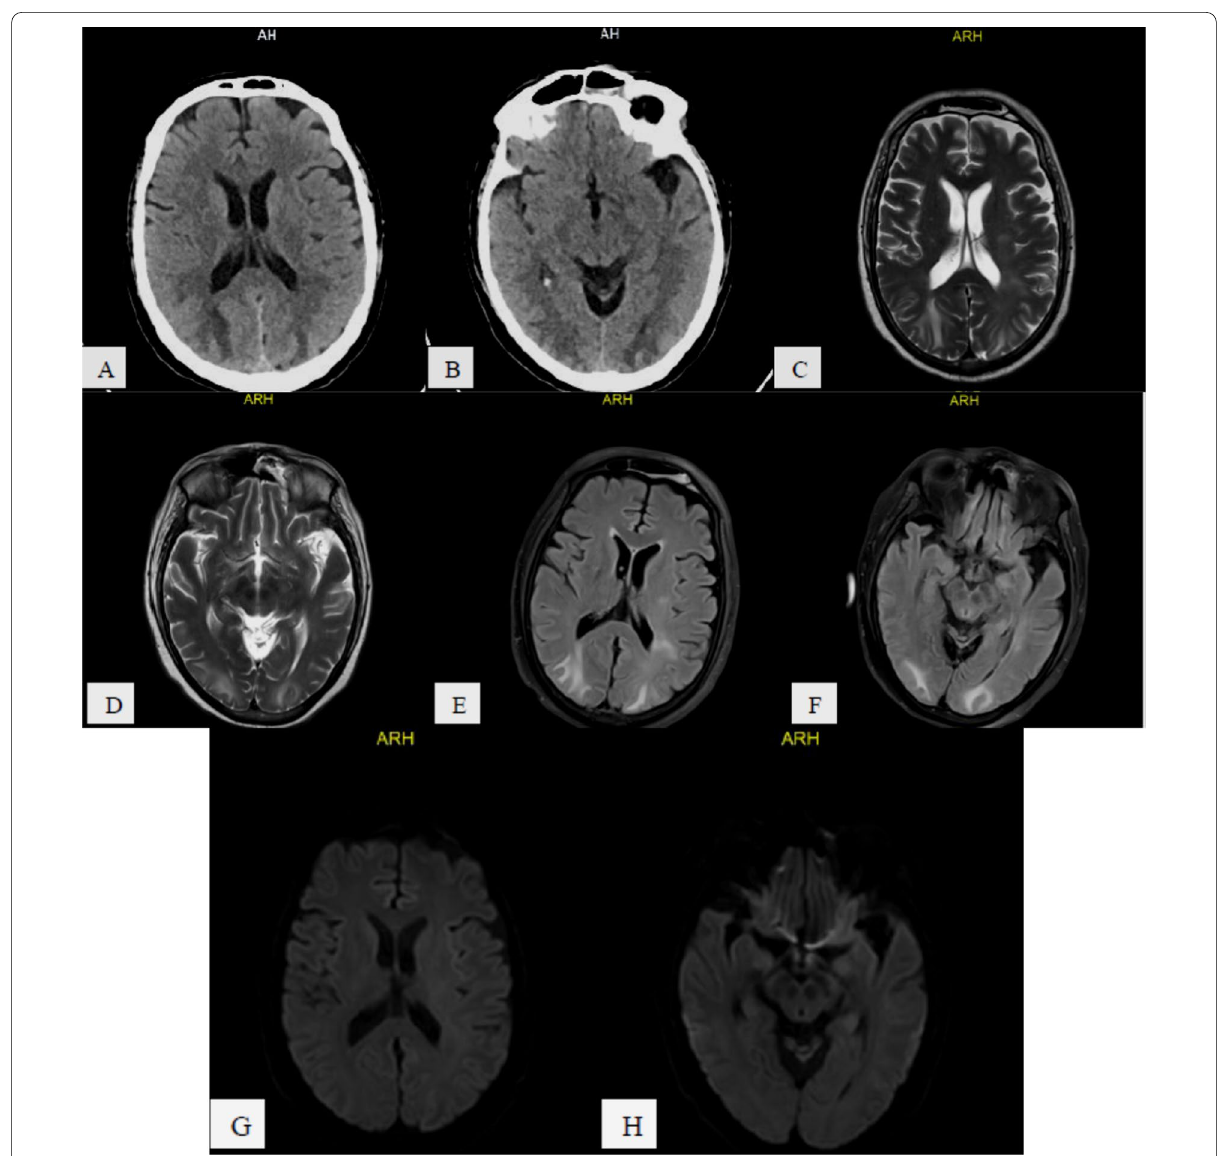
Fig. 4 47-year-old COVID-19 male patient with first time GTC seizure after prolonged ICU admission A , B axial CT images, C , D T2 WI, E , F FLAIR, G , H DWI showing bilateral posterior parieto-occipital and to less extent high frontal subcortical and deep white matter hyperintense signal noted on T2 and FLAIR images with morphological vasogenic edema pattern. No significant mass effect. It shows free diffusion features are impressive of morphological PRES ( posterior reversible encephalopathy syndrome